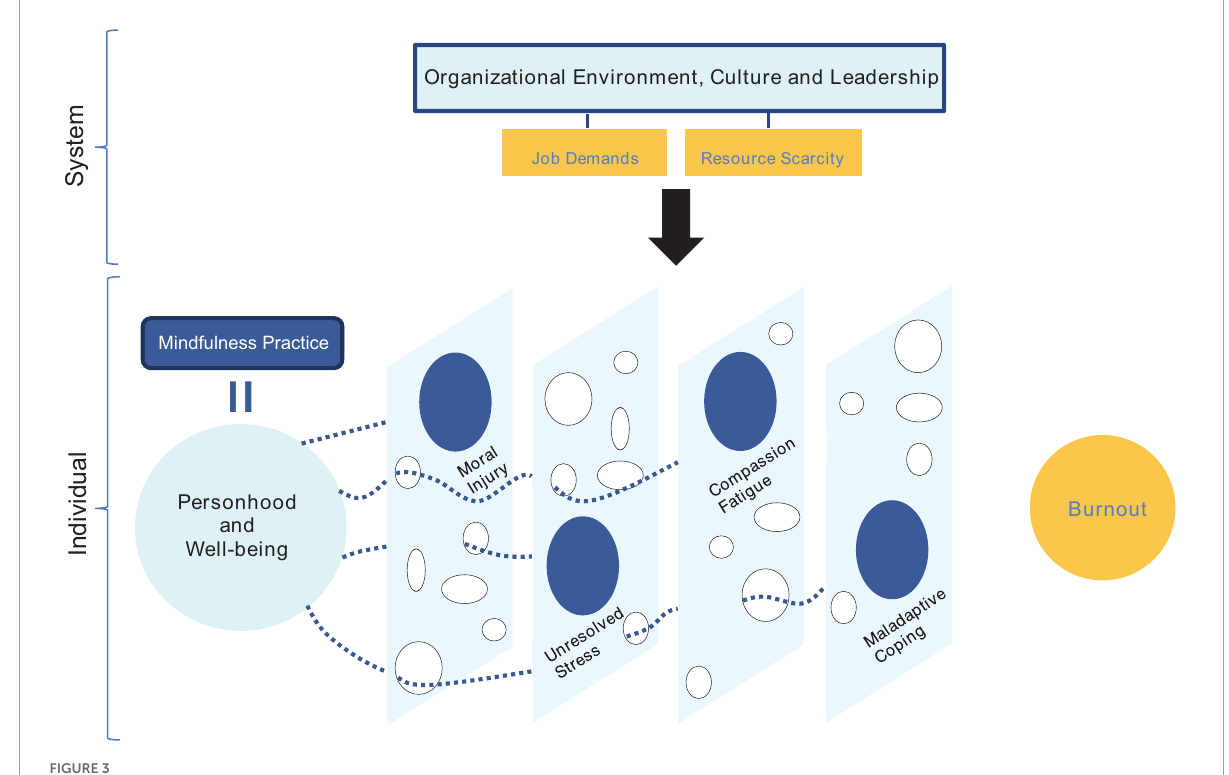
FIGURE3 The SIBS mindfulness practice model (authors’